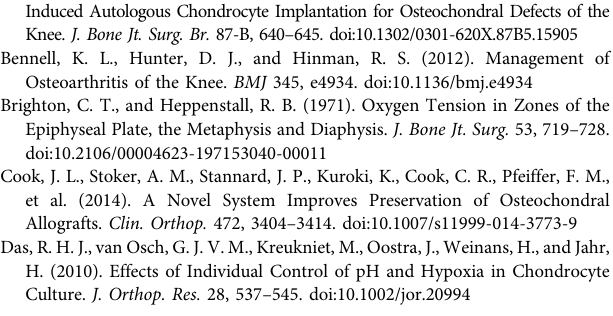
Supplementary Figure S4 | Cartilage aggregate images of donor 5 showing glycosaminoglycan (GAG) staining. Sections of cartilage aggregates from donor 5 over the four passages on each surface are shown here stained with safranin-O/ Fast Green. All at the same scale, scale bar 1 mm. See Supplementary Figures S2 – S4 for other donors. Supplementary Figure S5 | Cartilage aggregate images ofdonor 2showing type II collagen staining. Sections of cartilage aggregates from donor 2 over the four passages in each condition are shown here stained for type II collagen. All at the samescale,scalebar1 mm.See SupplementaryFiguresS5 – S7 forotherdonors. Supplementary Figure S6 | Cartilage aggregate images ofdonor 3showing type II collagen staining. Sections of cartilage aggregates from donor 3 over the four passages in each condition are shown here stained for type II collagen. All at the samescale,scalebar1 mm.See SupplementaryFiguresS5 – S7 forotherdonors. Supplementary Figure S7 | Cartilage aggregate images ofdonor 5showing type II collagen staining. Sections of cartilage aggregates from donor 5 over the four passages in each condition are shown here stained for type II collagen. All at the samescale,scalebar1 mm.See SupplementaryFiguresS5 – S7 forotherdonors. Supplementary Figure S8 | Cartilage aggregate images of donor 2 showing type I collagen staining. Sections of cartilage aggregates from donor 2 over the four passages in each condition are shown here stained for type I collagen. All at the same scale, scale bar 1 mm. See Supplementary Figures S8 – S10 for other donors. Supplementary Figure S9 | Cartilage aggregate images of donor 3 showing type I collagen staining. Sections of cartilage aggregates from donor 3 over the four passages in each condition are shown here stained for type I collagen. All at the same scale, scale bar 1 mm. See Supplementary Figures S8 – S10 for other donors. SupplementaryFigureS10| Cartilageaggregateimagesofdonor5showingtypeI collagen staining. Sections of cartilage aggregates from donor 5 over the four passages in each condition are shown here stained for type I collagen. All at the same scale, scale bar 1 mm. See Supplementary Figures S8 – S10 for other donors. Supplementary Figure S11 | Cartilage aggregate images of donor 2 showing type X collagen staining. Sections of cartilage aggregates from donor 2 over the four passages in each condition are shown here stained for type X collagen. All at the same scale, scale bar 1 mm. See Supplementary Figures S11 – S13 for other donors. Supplementary Figure S12 | Cartilage aggregate images of donor 3 showing type X collagen staining. Sections of cartilage aggregates from donor 3 over the four passages in each condition are shown here stained for type X collagen. All at the same scale, scale bar 1 mm. See Supplementary Figures S11 – S13 for other donors. Supplementary Figure S13 | Cartilage aggregate images of donor 5 showing type X collagen staining. Sections of cartilage aggregates from donor 5 over the four passages in each condition are shown here stained for type X collagen. All at the same scale, scale bar 1 mm. See Supplementary Figures S11 – S13 for other